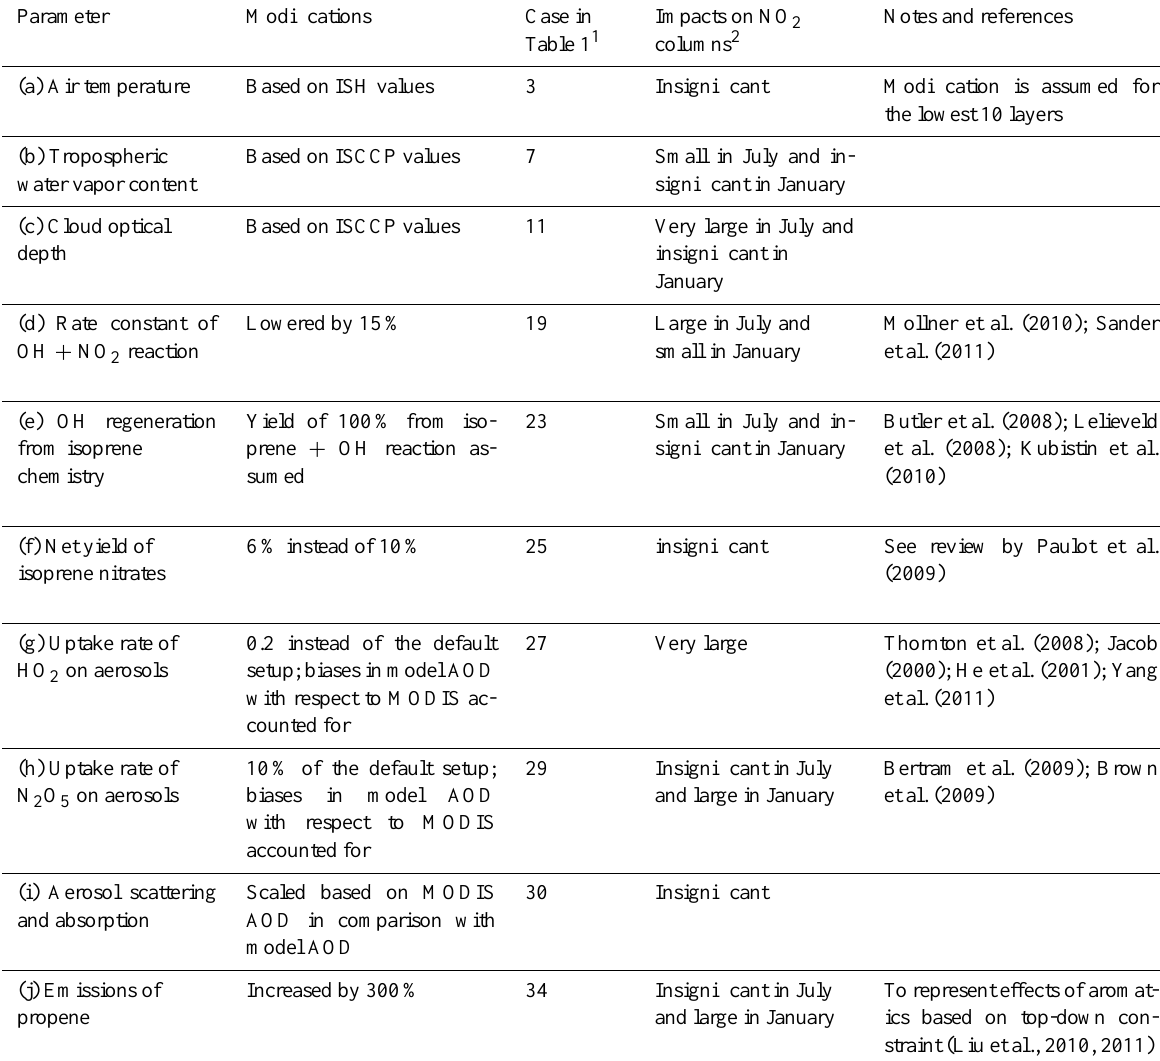
Table 2. Parameters considered in post-model modification for NO 2 columns at the 284 meteorological stations in East China. Parameter Modifications Case in Impacts on NO